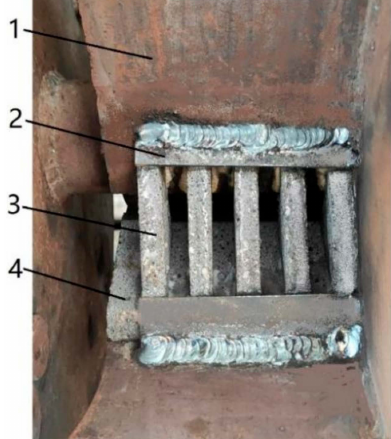
Figure 9. The installation position of the foamed aluminium material of the throwing blade. (1) Throwing blade; (2) steel plate; (3) triangular aluminium foam; (4) square aluminium